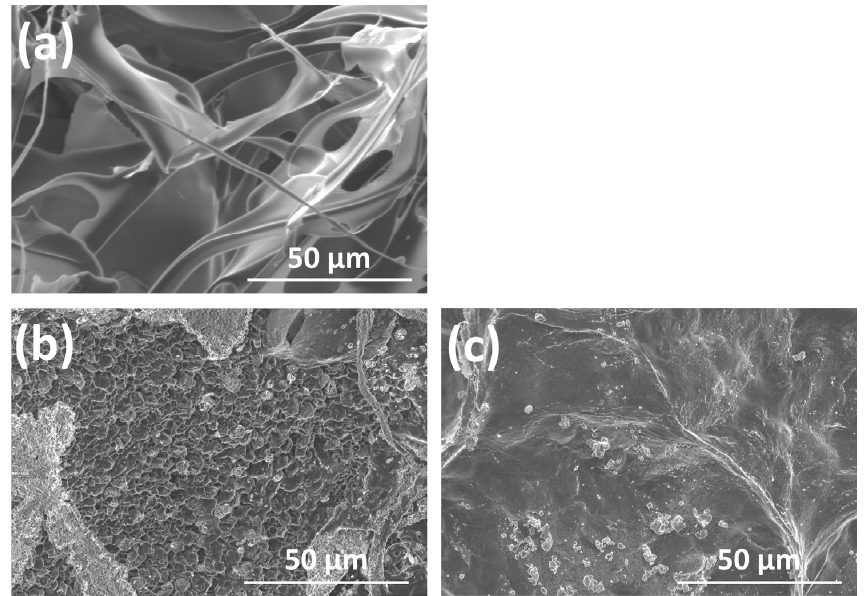
Figure 8. SEM photo-micrographs of dried ( a ) HyA control, ( b ) ux-tHyA, and ( c ) x-tHyA.